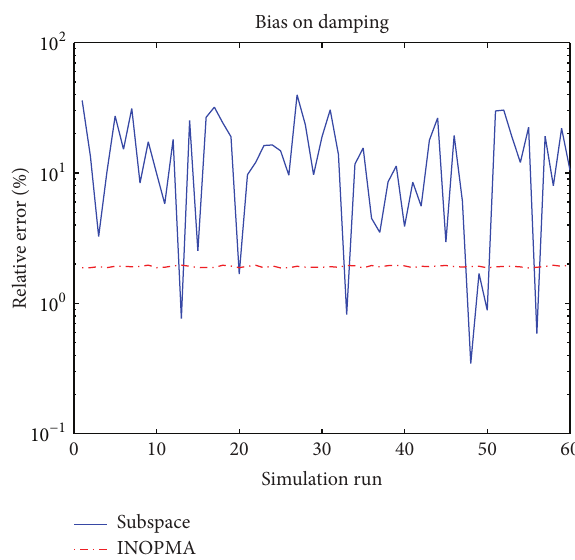
Figure 2: Variance on frequency: SDOF case.